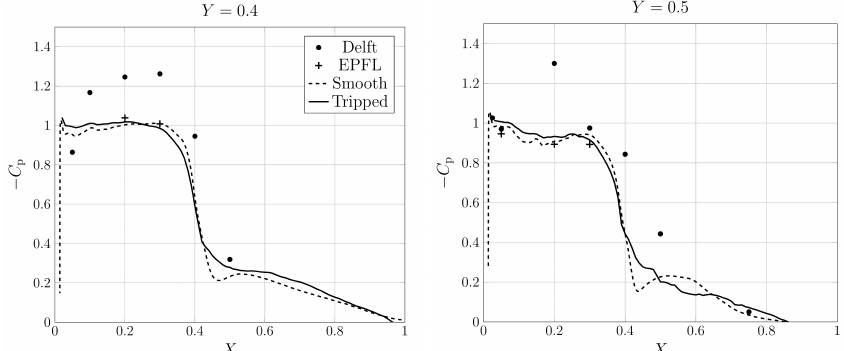
Figure 5. Distribution of the pressure coefficient at different sections of the Twist11